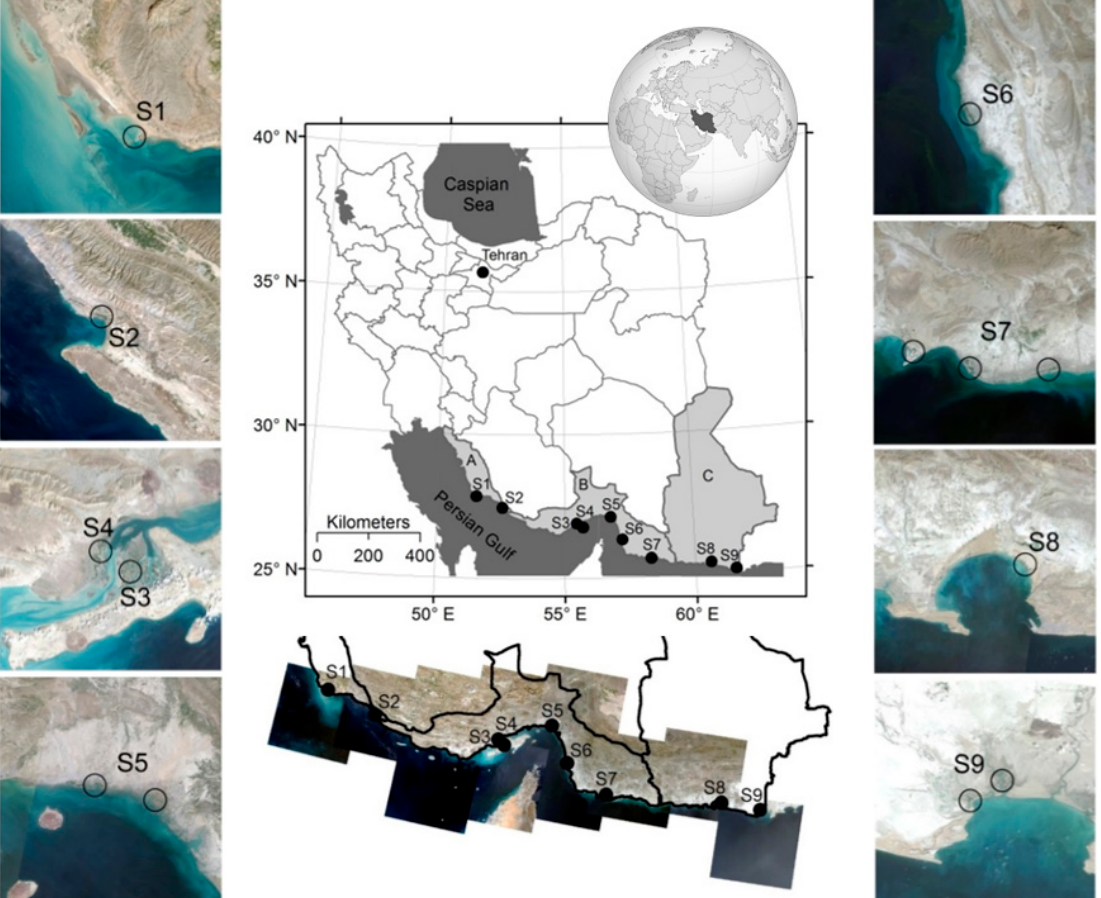
Figure 1. Spatial distribution of all major mangrove sites in Iran investigated in this study, i.e., S1 and S2 in Bushehr Province ( A ), S3–S7 in Hormozgan Province ( B ), and S8 and S9 in Sistan and Baluchestan Province ( C ). The sites were shown on Landsat 8 mosaic images (R = Band 3, G = Band 2, B = Band 1) collected in March 2020, with the overlay of administrative boundaries of Bushehr Province, Hormozgan Province, and Sistan and Baluchestan Province.